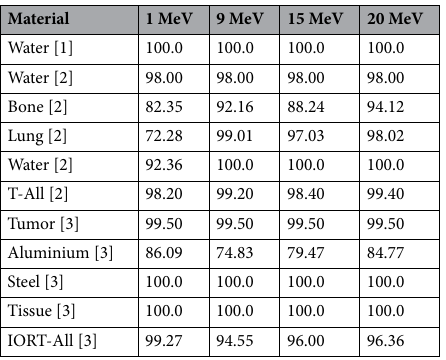
Table 1. Percentage of voxels satisfying the AAPM 2% criterion for a relative BFP-MC error below 2% . Listed values include buildup, interfaces and straggling regions. From top to bottom, the three showed sections are: the W-benchmark, the T-benchmark (and its materials) and the IORT-benchmark (and its